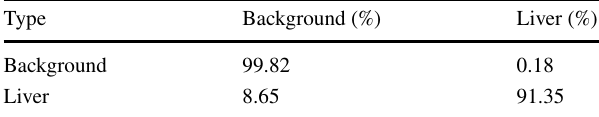
Table 5 Experimental confusion